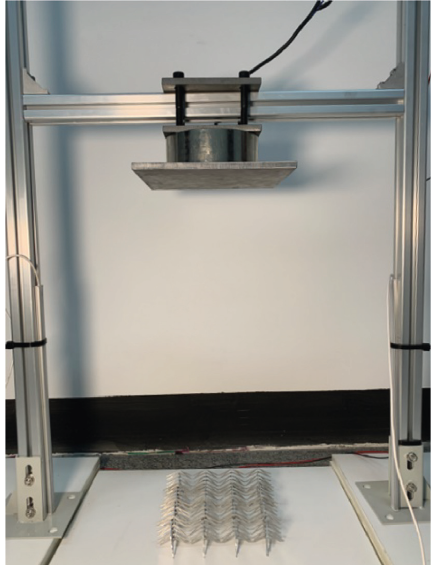
Figure 9: Impact testbed.